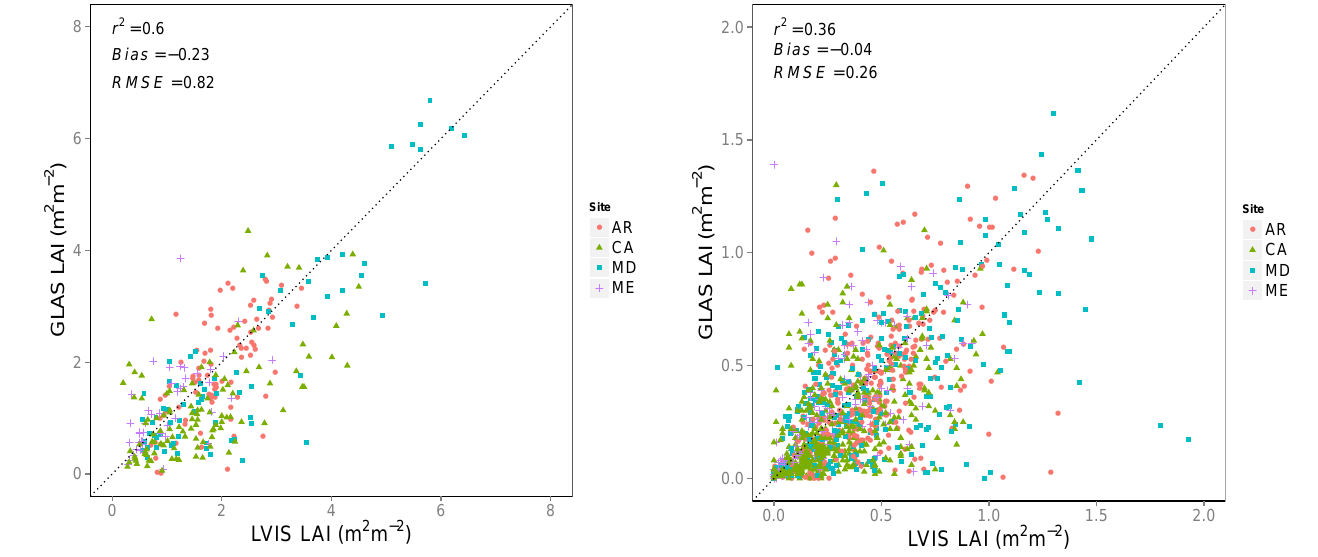
Figure 2. A comparison of vertical foliage profile (VFP) density derived from LVIS and GLAS over different sites in the US (same sites as Fig. 1 but with N = 1272). Each VFP point represents an integrated value of foliage density at each 5m height